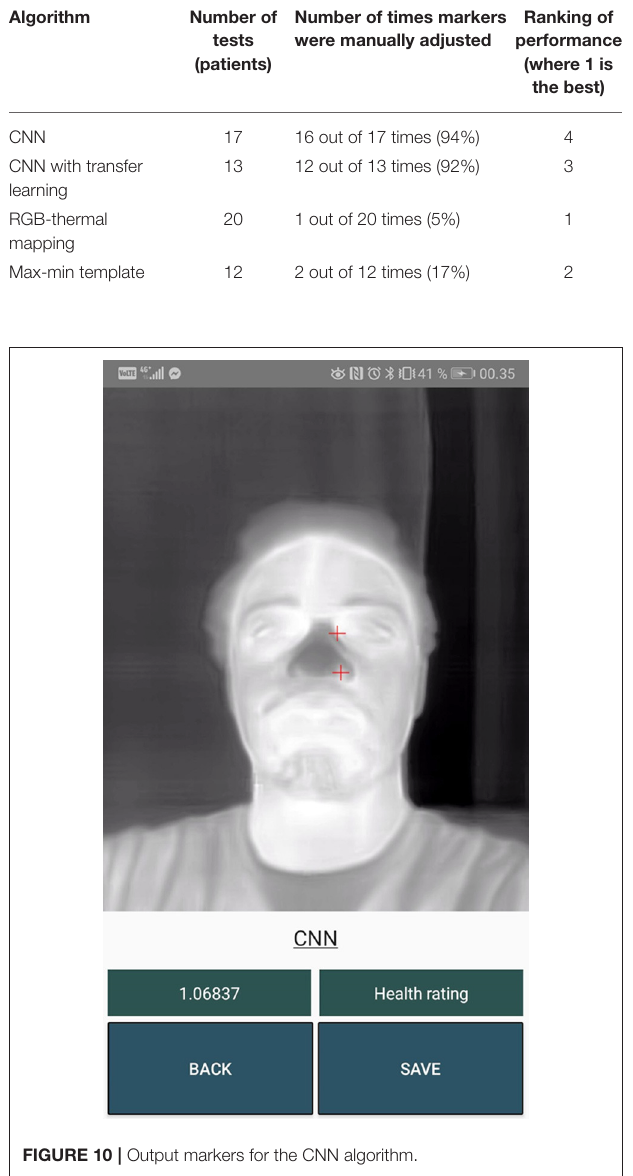
FIGURE 10 | Output markers for the CNN algorithm.